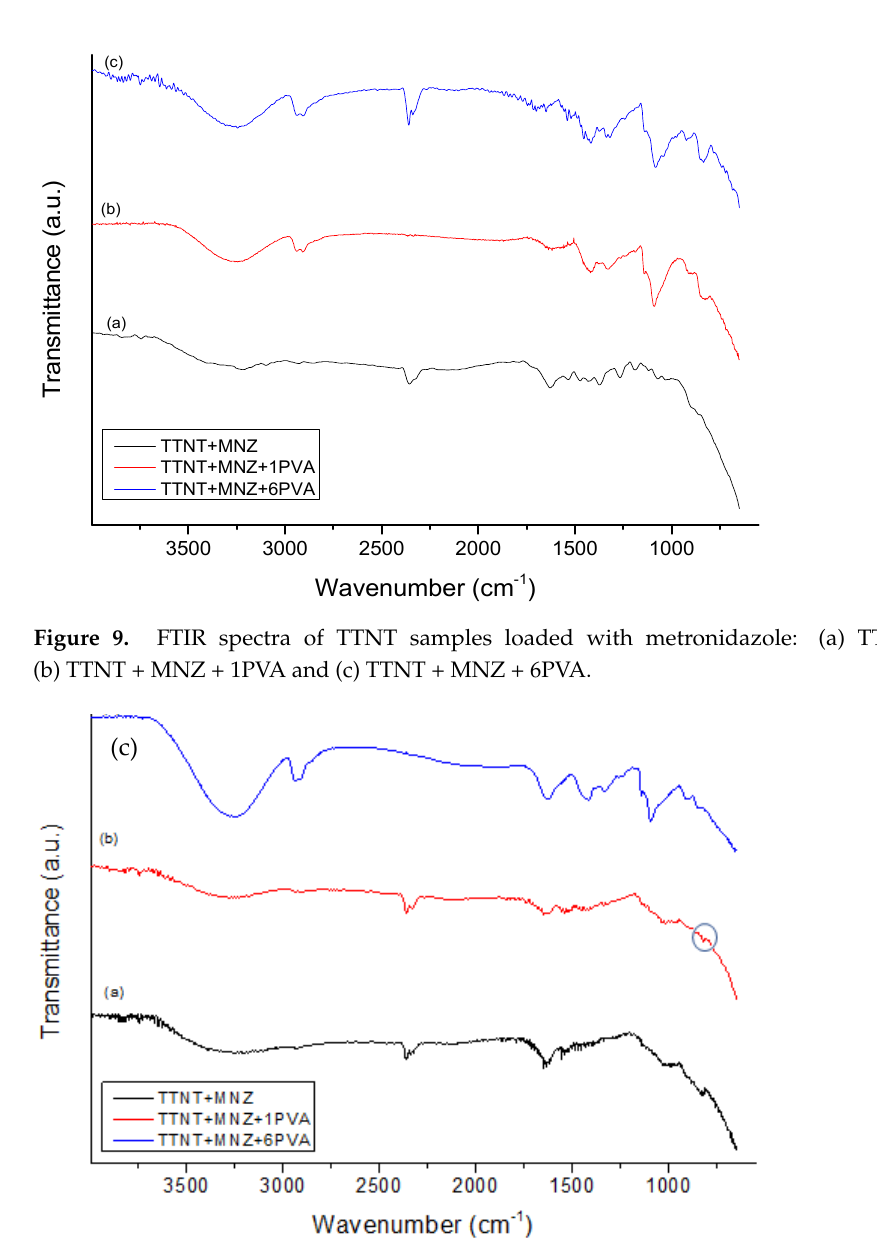
Figure 10. FTIR spectra of TTNT samples loaded with metronidazole, (a) TTNT + MNZ, and coated with PVA, (b) TTNT + MNZ + 1PVA and (c) TTNT + MNZ + 6PVA, after 14 days of immersion in PBS solution at 37 °C.